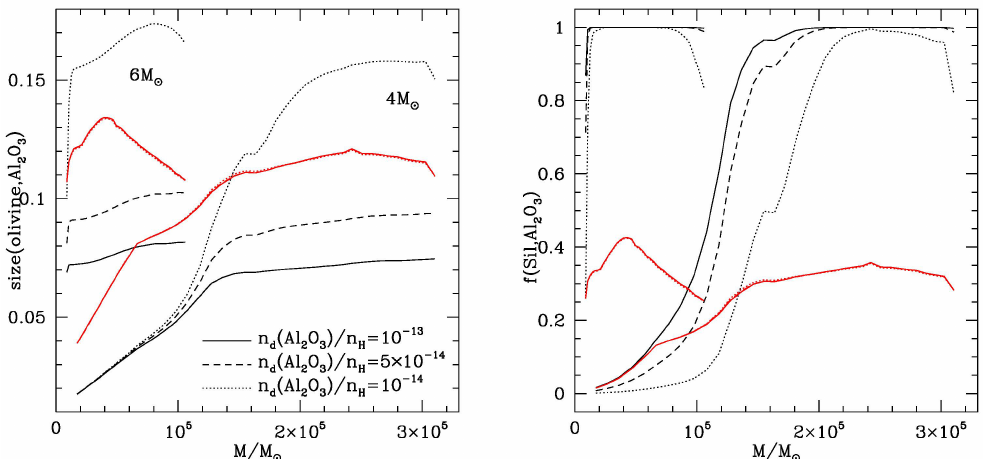
Figure 9. The AGB variation of the size of olivine (red lines) and Al 2 O 3 particles ( Left ) and of the fraction of silicon and aluminium condensed into silicates and alumina dust, respectively ( Right ), of the model stars of initial mass 4 M (cid:12) and 6 M (cid:12) . The different lines refer to the choices regarding the seed density of Al 2 O 3